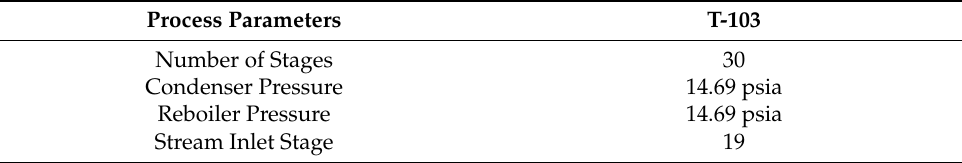
Table 2. Distillation column process parameters.